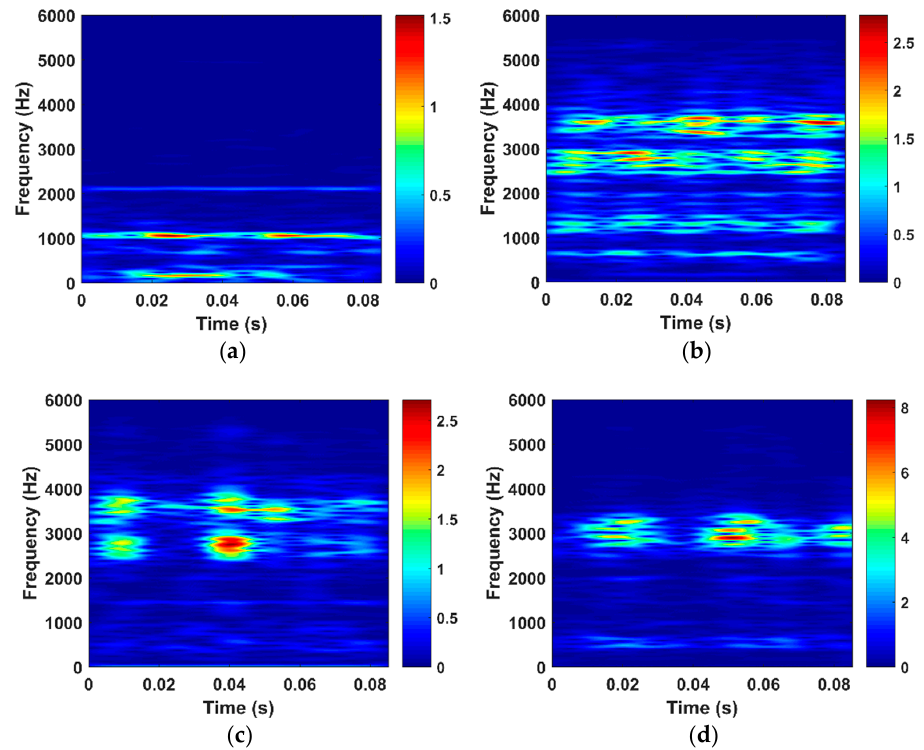
Figure 7. Time-domain waveforms of the vibration signals of bearings with four different faults severity degrees at the inner race: ( a ) 0.000 in, ( b ) 0.007 in, ( c ) 0.014 in, and ( d ) 0.021 in.